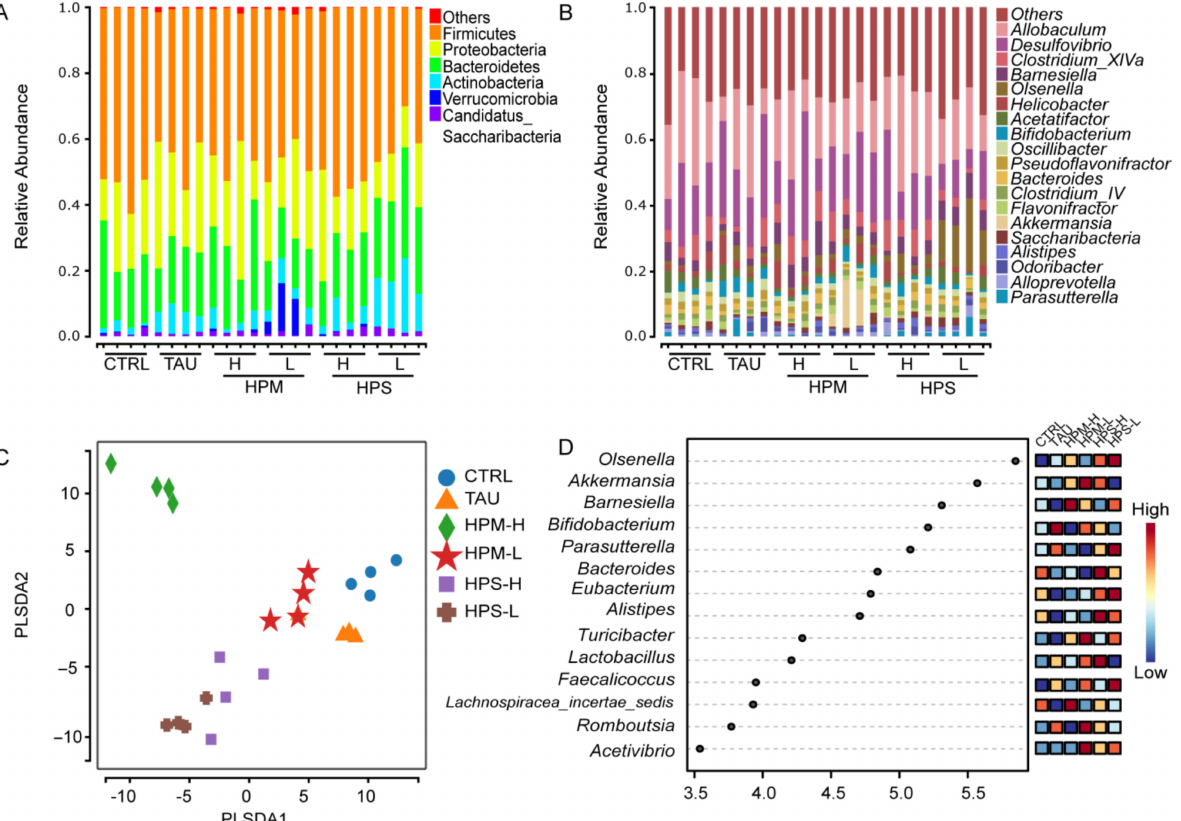
Figure 3. Effects of the spore and mycelia of Paecilomyces hepiali on the gut microbial composition. ( A ) Relative abundance of phyla; ( B ) Relative abundance of genera; ( C ) Partial least squares Dis- criminant Analysis, (PLS-DA); ( D ) Linear discriminant analysis Effect Size (LEfSe). The selected classification level was the genus level, the analysis method was Kruskal Wallis test, and the threshold of the log-linear discriminant analysis score was